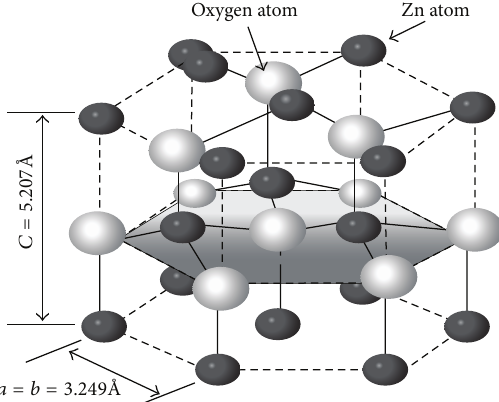
Figure 1: Tetrahedral structure of